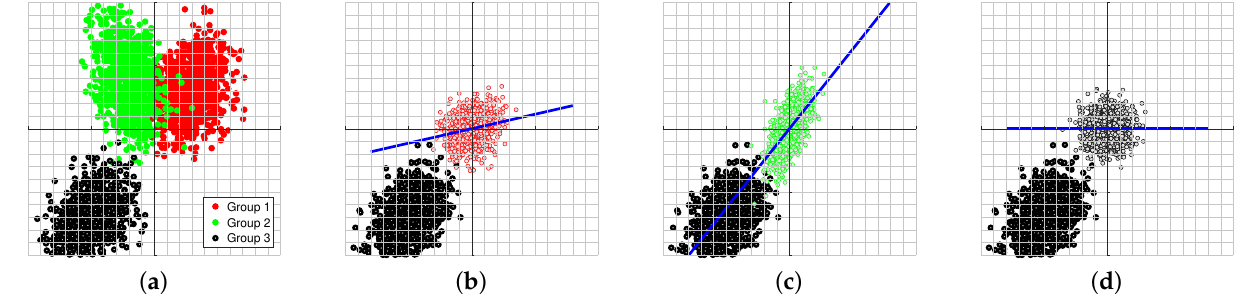
Figure 1. The “unknown” data, shown in black, are repeatedly projected on the spaces spanned by the eigenvectors of other groups. When the principal axis of the projected data aligns with the reference axis, a match is declared. In this example, the source of the unknown data is the group shown in black. ( a ) Three multivariate normal data sets simulating different signal sources, ( b ) Black data is whitened by the red whitening matrix, ( c ) Black data is whitened by the green whitening matrix, ( d ) Black data is whitened by its own whitening matrix.